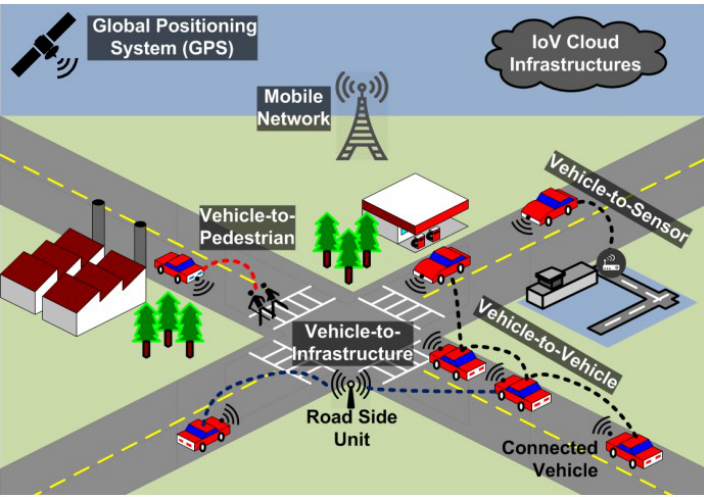
Figure 3. The ITS communication architecture in smart cities